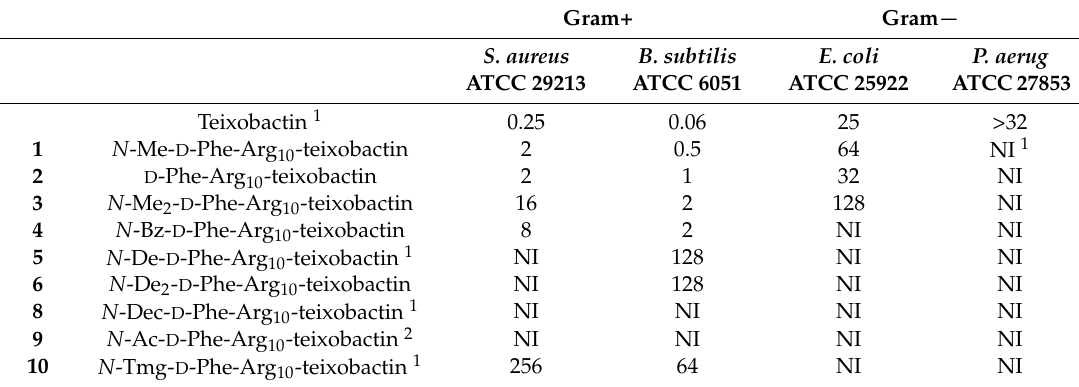
Table 1. Minimum Inhibitory Concentration (MIC) ( µ g/mL) for teixobactin analogs ( 1 – 6 , 8 – 10 ). Gram+ Gram